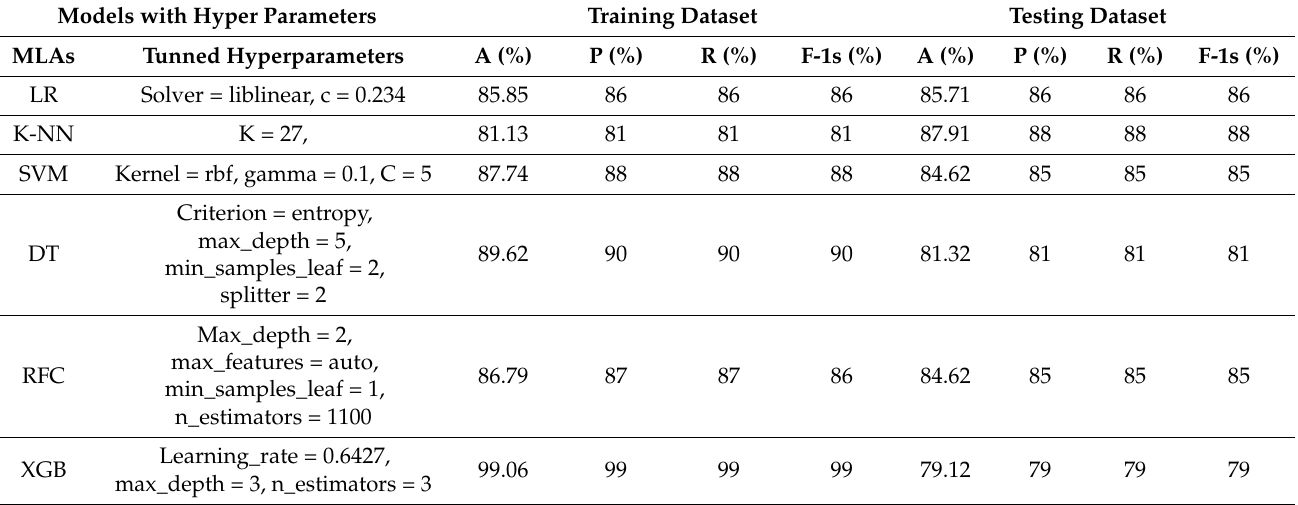
Table A2. The classification model results for the training and testing datasets using a hyperparameter tuning